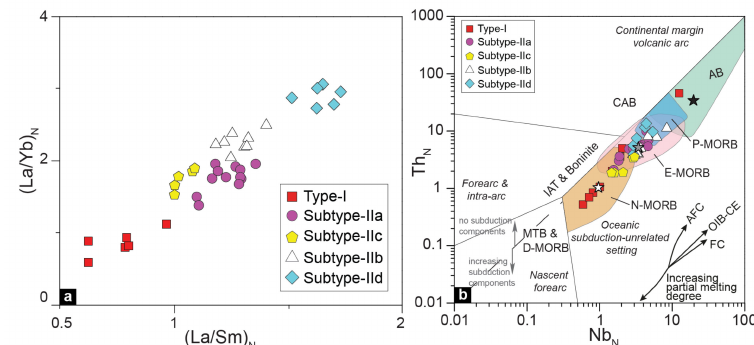
Figure 10. Chondrite-normalized (La / Sm) N vs. (La / Yb) N diagram ( a ) and N-MORB-normalized Th vs. Nb discrimination diagram of Saccani [9] ( b ) for volcanic and subvolcanic rocks from the sheeted dyke complex and volcanic sequence of the Band-e-Zeyarat ophiolite. Vectors in ( b ) indicate the trends of compositional variations due to the main petrogenetic processes. Abbreviations: AFC: assimilation- fractional crystallization; OIB-CE: ocean island-type (plume-type) component enrichment; FC: fractional crystallization; MORB: mid-ocean ridge basalt; N-: normal type; E-: enriched type; P-: plume